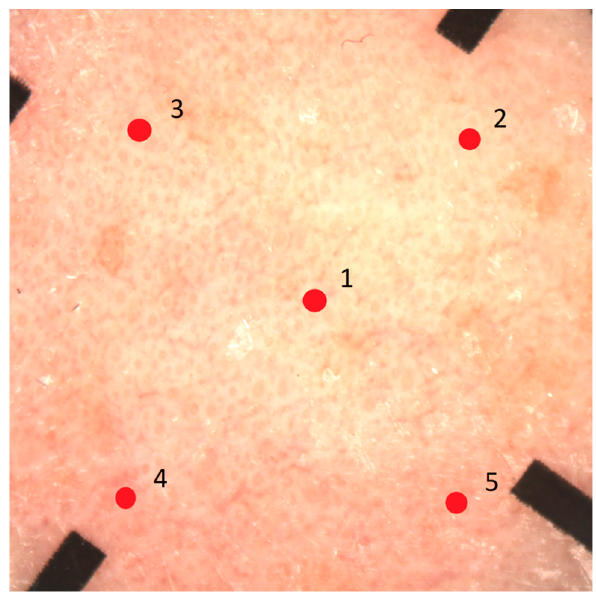
Figure 2. Dermoscopic image of the cheek made using the reflectance confocal microscope. The red dots show the exact locations were the VivaStacks were performed.